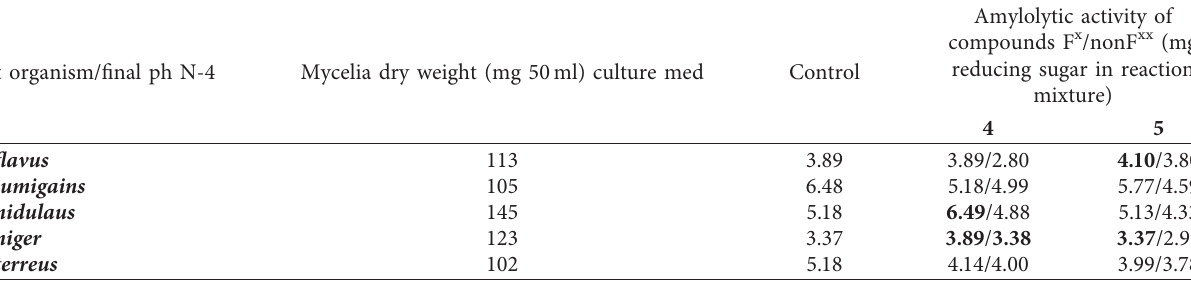
Table 1: The effects of fluorinated/nonfluorinated α -amino acids on the activity of the crude amylase.